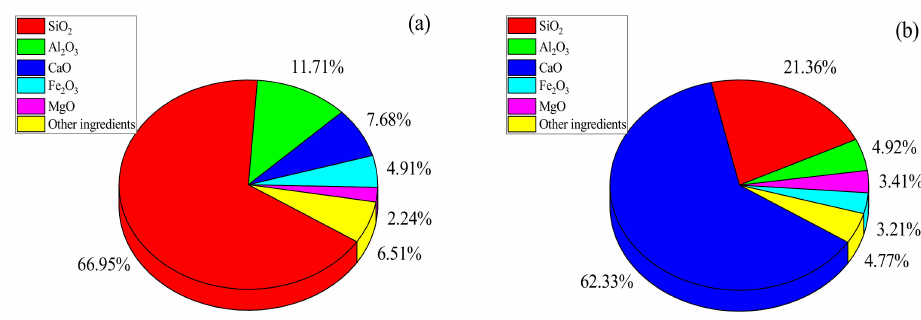
Figure 2. The PSD curves of the tailings.